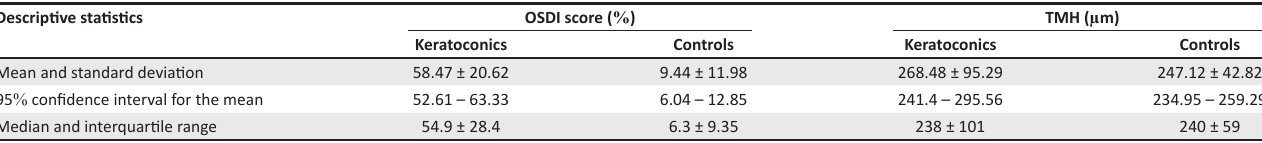
TABLE 2: Descriptive statistics for the data collected from the two subject groups. Descriptive